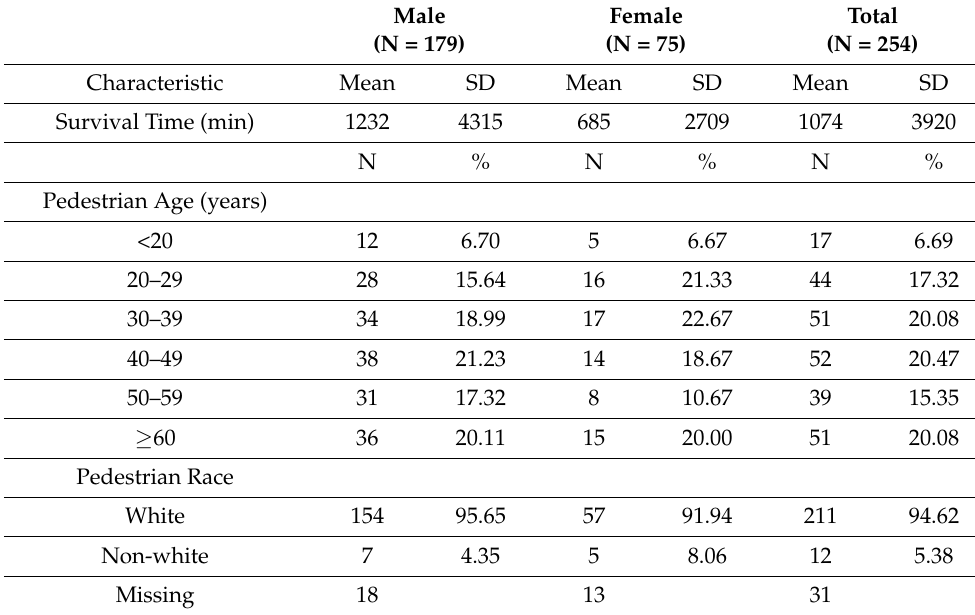
Table 1. Characteristics of fatal pedestrian crashes that occurred in West Virginia, 2009–2019 stratified by sex